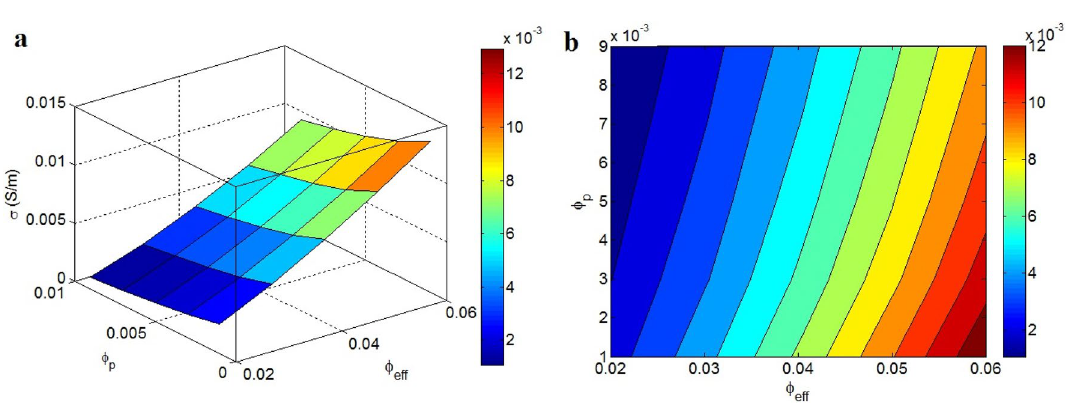
Figure 6. Effects of ρ and f on conductivity by ( a ) 3D and ( b ) contour illustrations.